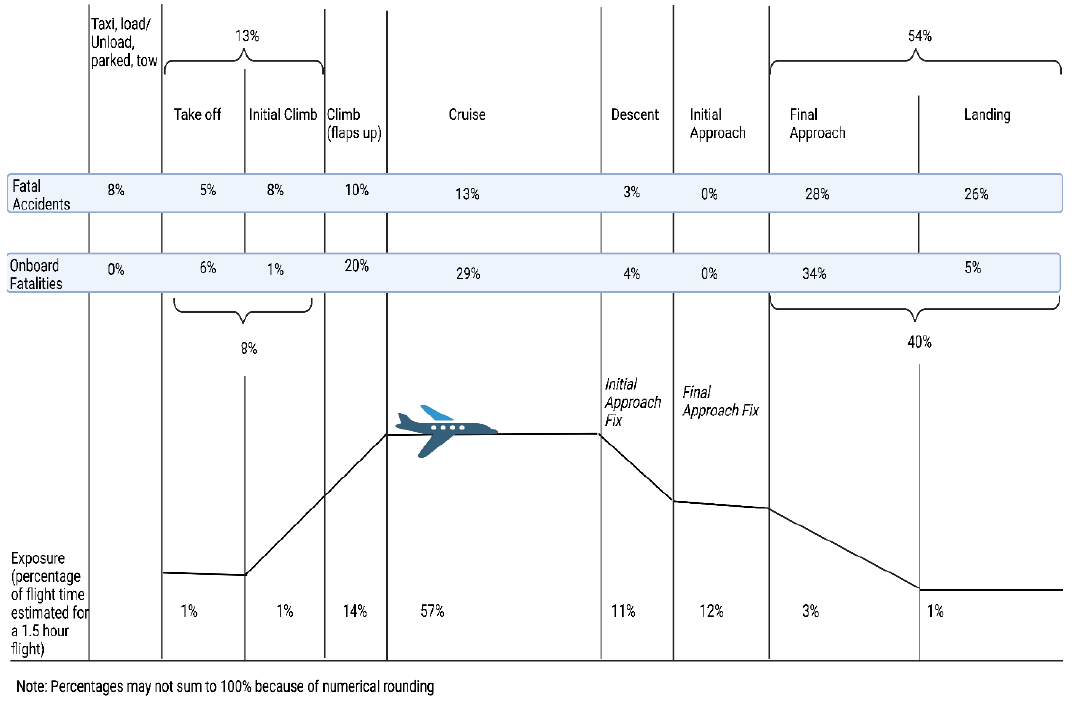
Figure 2. Phase wise fatal accidents (2011 – 2020) [20] (Image created using BioRender.com).